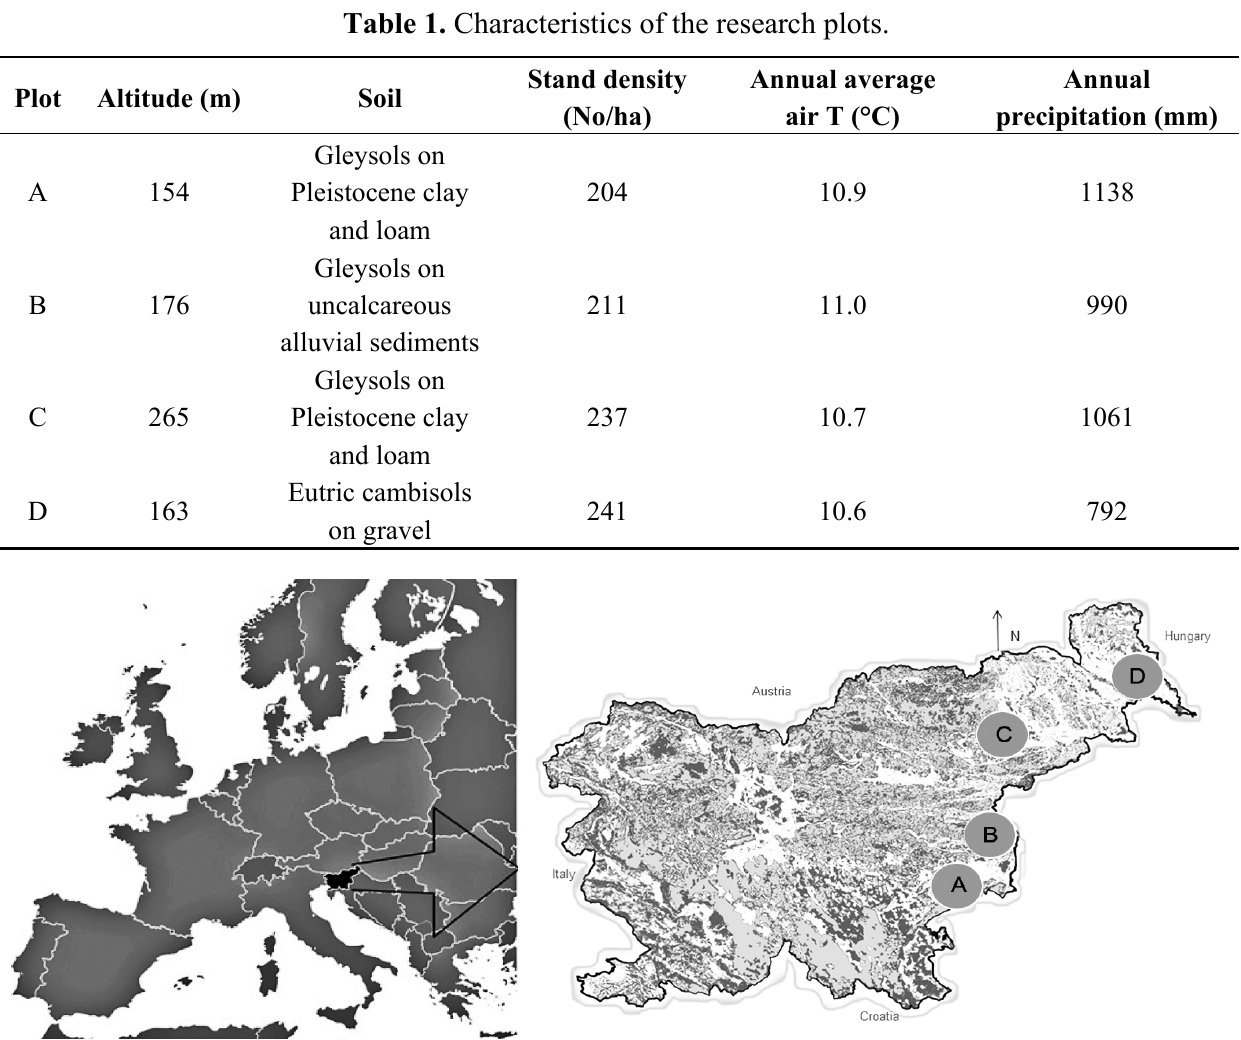
Figure 1. Location of the research plots in the forested area of